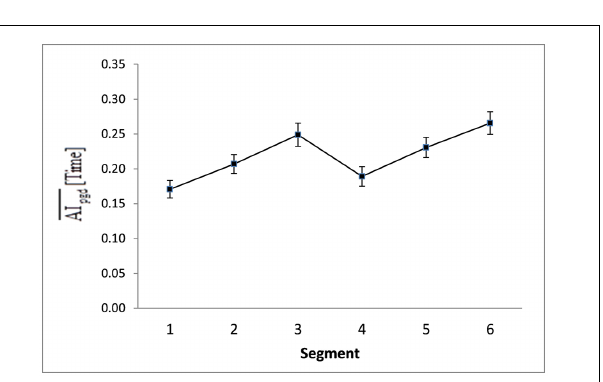
FIGURE 3 | Mean RMSE and standard errors of right and left hand performances by practice day as averaged over all segments (s) of all respective performance hand trials (t) of all participants (p) of all age groups (g). The mean RMSE scores of right vs. left hand performance were significantly different on Days 2 and 3 ( p < 0.05).